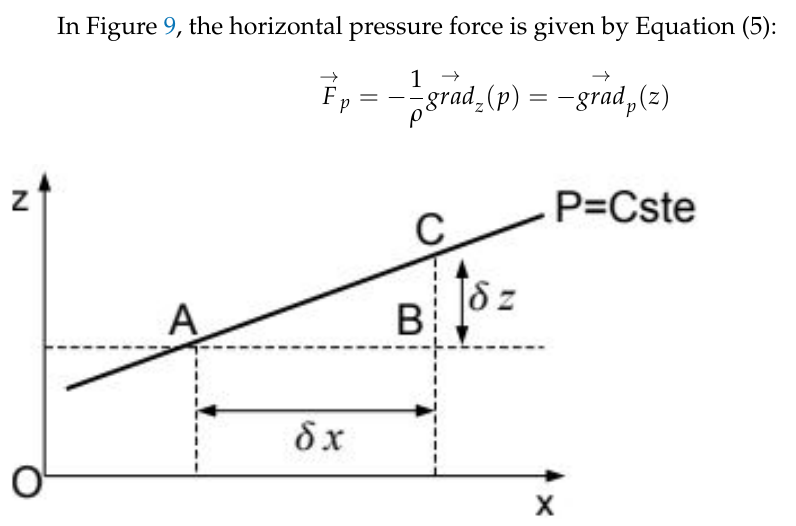
Figure 9. Equivalence between pressure and altitude differences: points A and B are at the same altitude, A and C at the same pressure. The pressure at B is therefore higher than at C.